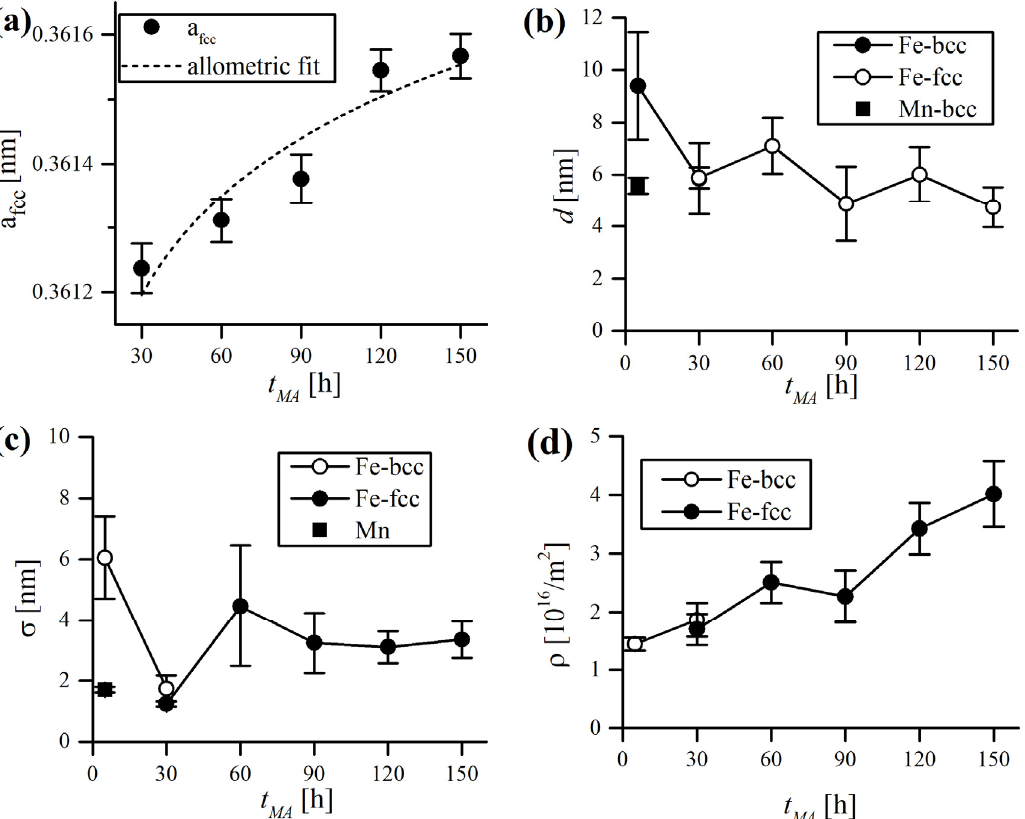
Figure 9. Basic microstructural data derived from WPPM refinement in terms of the progression of following the parameters during MA: ( a ) lattice parameter, ( b ) lognormal domain size, ( c ) lognormal standard deviation, ( d ) dislocation density. Error bars correspond to the estimated standard deviation of the WPPM fit.